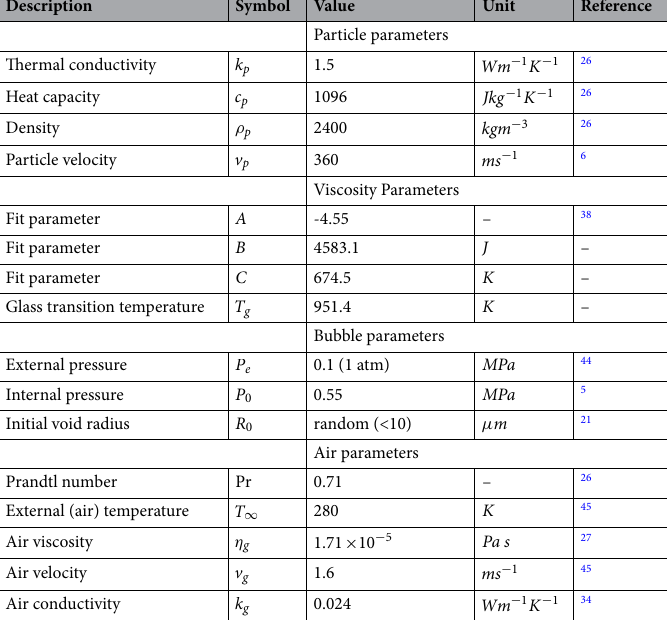
Table 2. Parameter values utilised in the presented